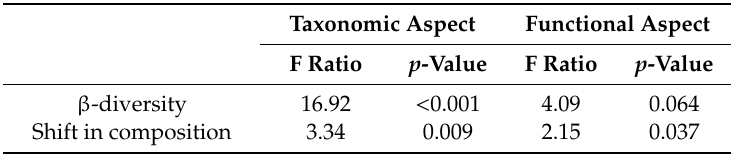
Table 4. Di ff erences in β -diversity and composition in the floodplain landscape, according to three groups of degradation levels. Note: di ff erence in β -diversity was tested with ANOVA by permutations on site–centroids distances and di ff erence in location of centroid was tested with